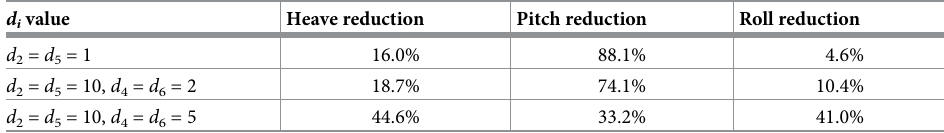
Table 2. Different control effects in different fitness functions.